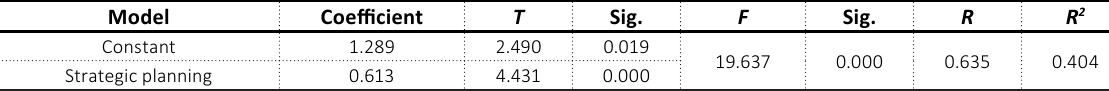
Table 5. The impact of strategic planning on the financial perspective